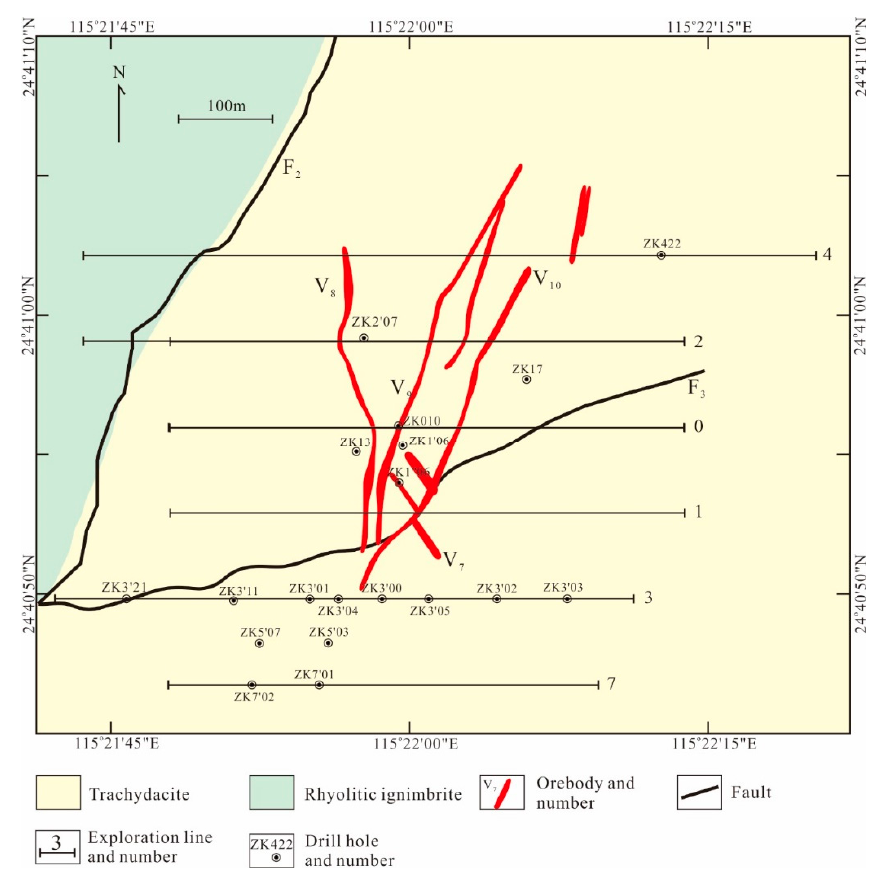
Figure 2. Geological schematic map of the Tiantangshan tin polymetallic deposit.